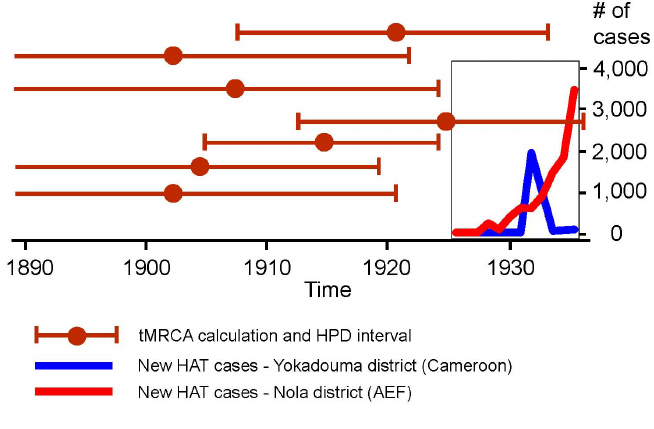
Figure 3. The recent tMRCA calculations of HIV-1 M (with high probability (HPD) distribution intervals), and the timings of systematic treatments against human African trypanosomiasis (HAT) in the districts of Yokadouma (Cameroon) and Nola (Afrique Équatoriale Française). Sources: (1) on tMRCA calculations: [27,30]; (2) on HAT treatments: